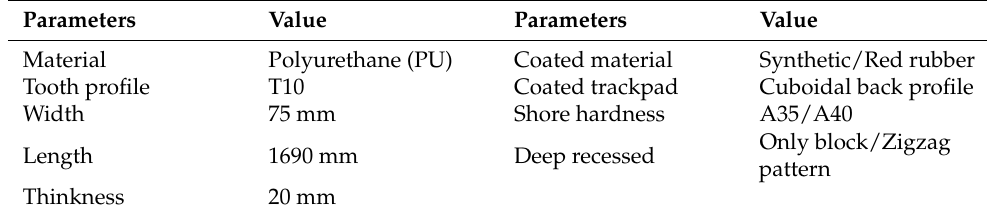
Table 1. Physical parameters of rubber wheel